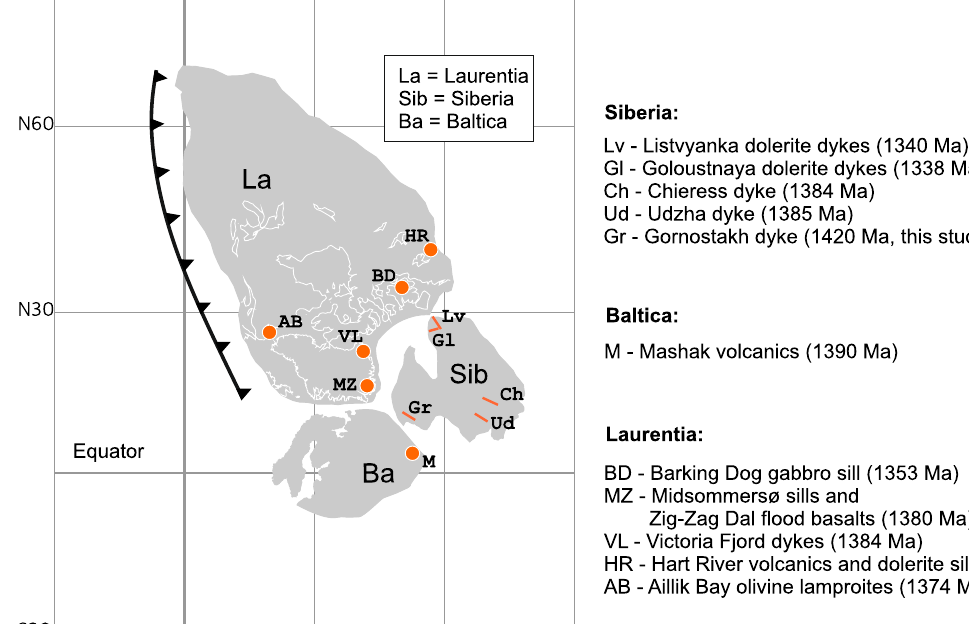
M 34 , AB 36 , BD 8 , MZ and VL 35 , HR 37